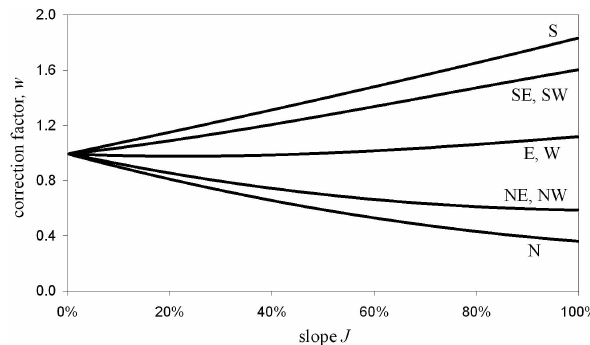
Fig. 11. Correction factor w for the actual evapotranspiration ET act calculated for flat catchments, as a function of the mean slope of the basin and its orientation (N: north, S: south, E: east; W: west); adapted from DVWK